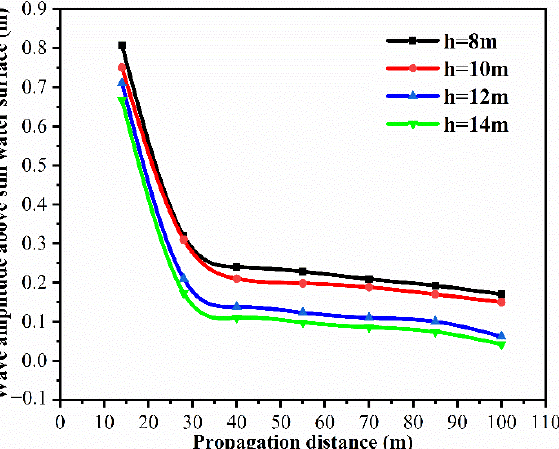
Figure 5. Variation of wave amplitude above still water level with propagation distance in different water